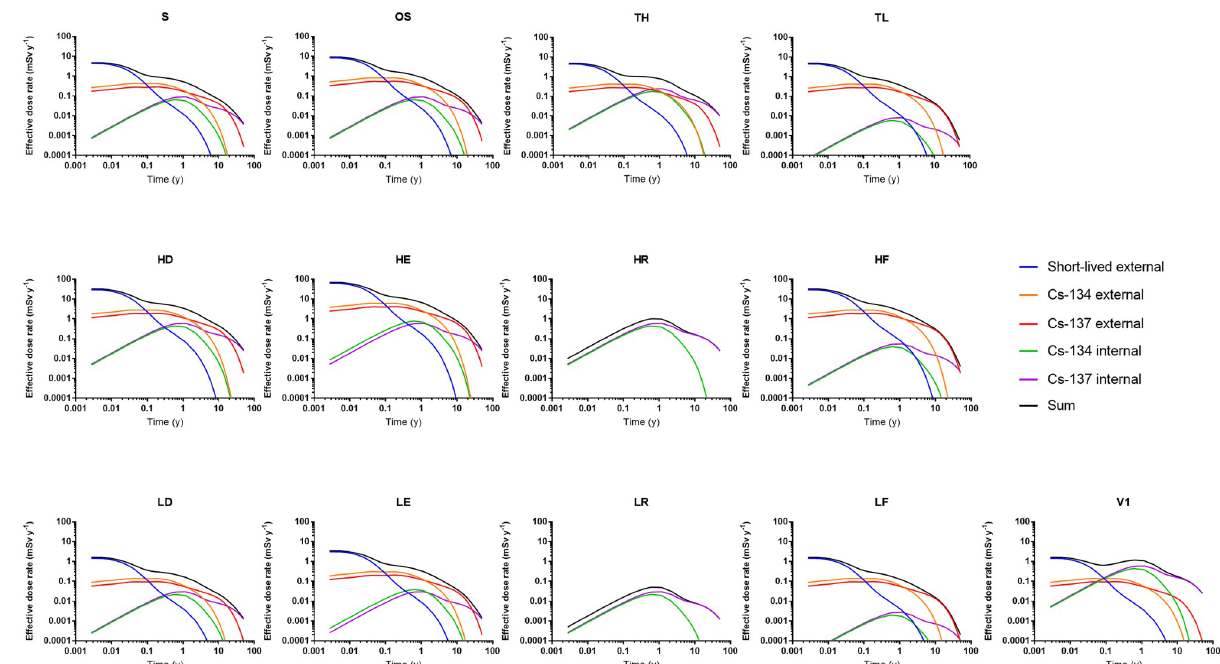
Fig 2. Effective dose rate (mSv y -1 ) for adult males during the 50 years following fallout, assuming the various scenarios described in Table 2.